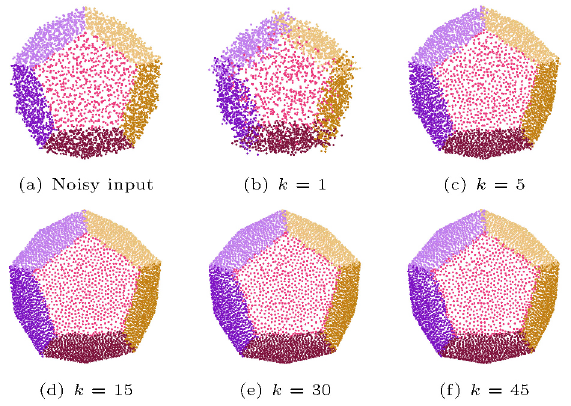
Fig. 13 Filtered results for different k . Noise level: 1.0%, t = 30, µ = 0.3.